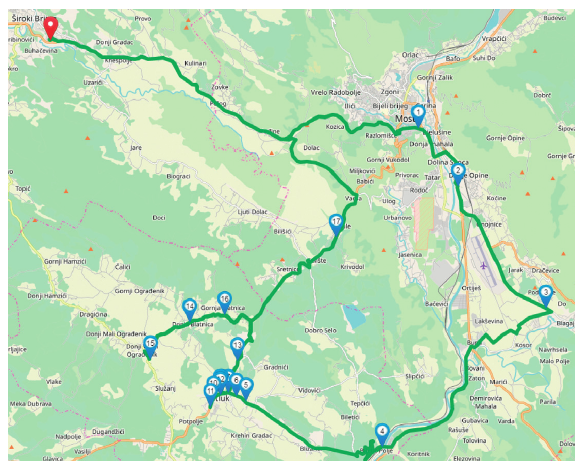
Figure 5: Example of a typical delivery for one vehicle. Table 5: Comparative results of the used regression models.